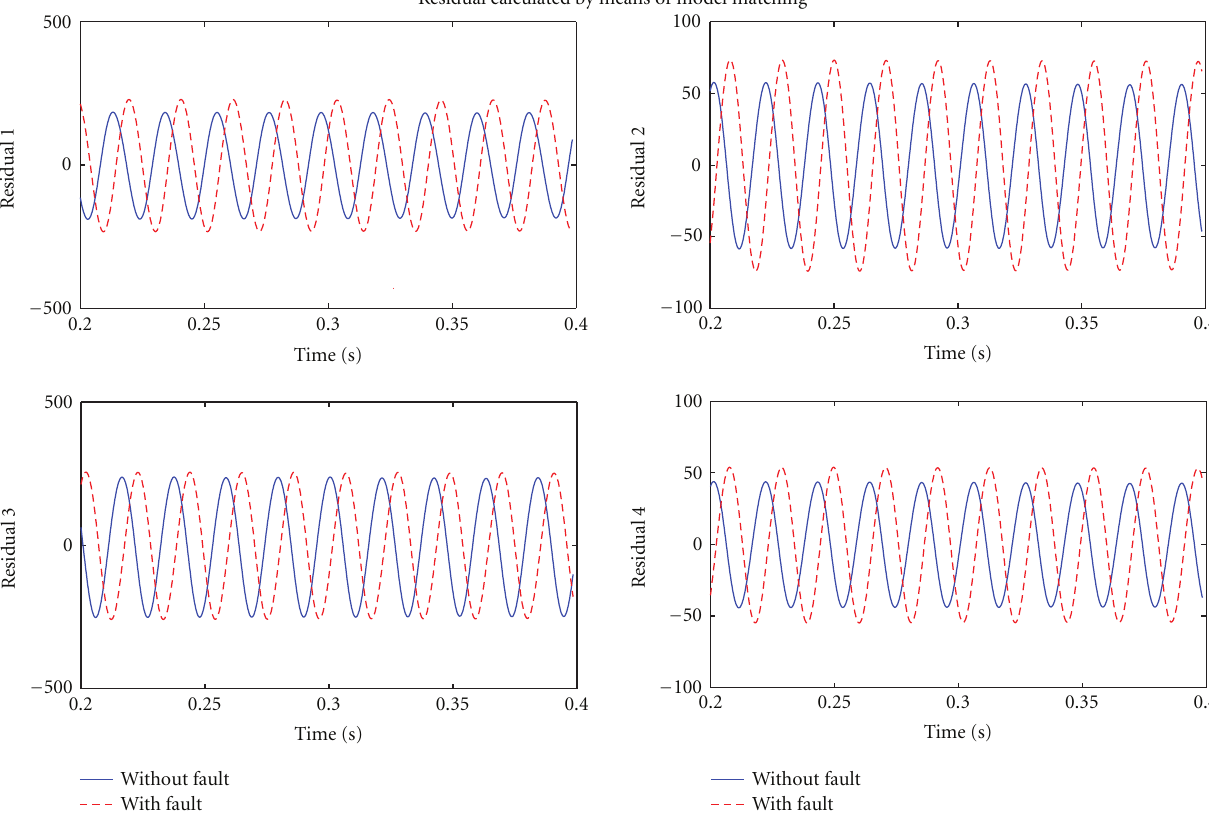
Figure 11: Residual generated by means of model